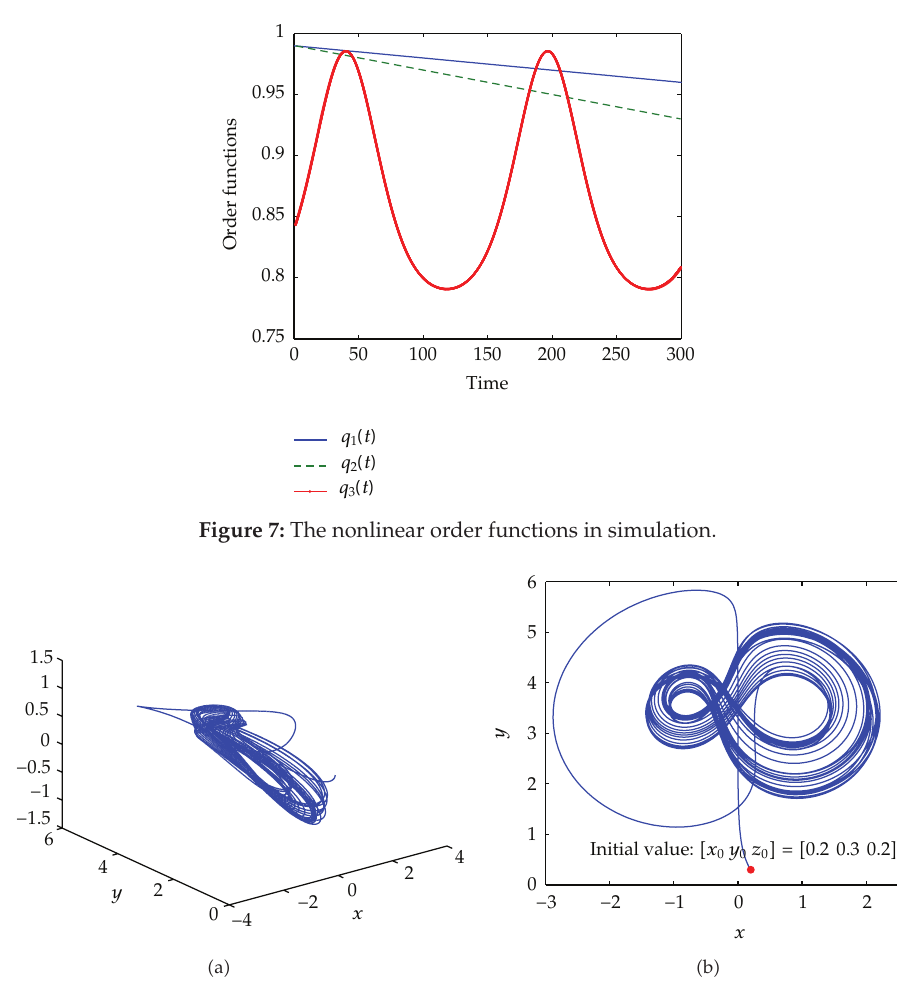
Figure 8: The numerical solution of Example 4.2 with step size h (cid:7) 0 . 02 and nonlinear order functions (cid:3)(cid:3) a (cid:4) 3D portrait; (cid:3) b (cid:4) x - y projection (cid:4)